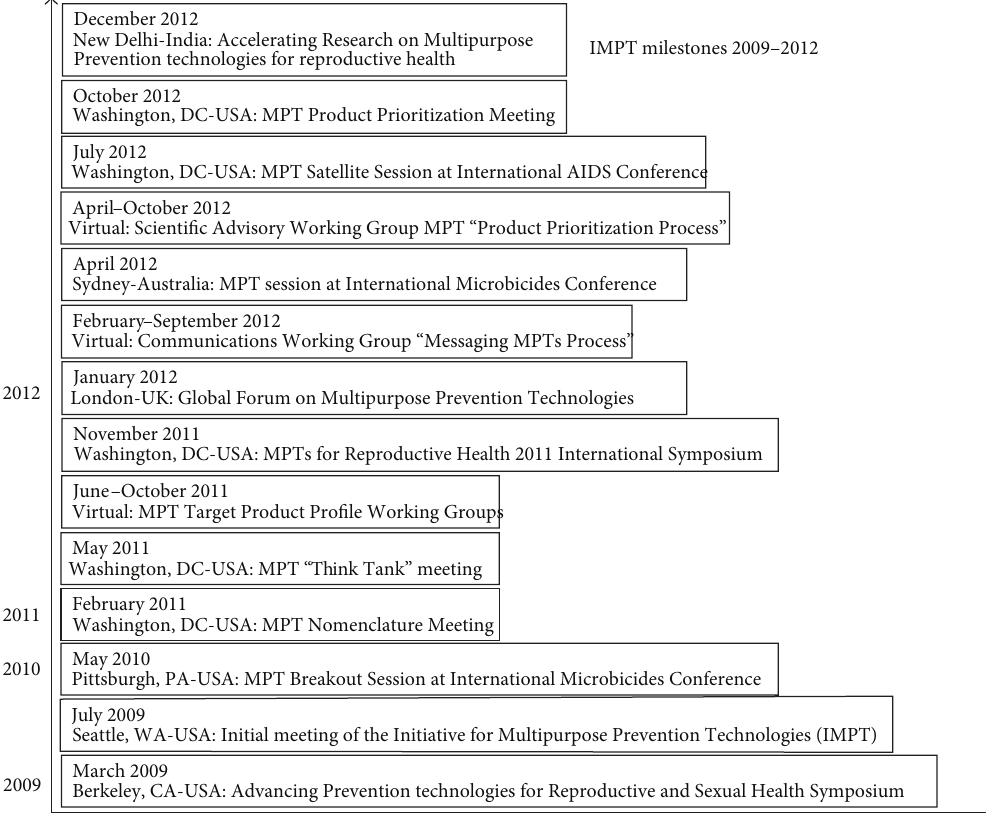
Figure 1: MPT Strategic Milestones